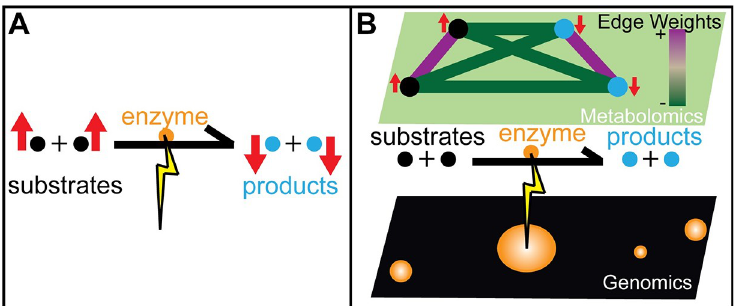
Fig 2. Latent covariance structure in the metabolome is induced by genetic perturbations of an enzyme. (A) Pathway visualization can unveil bottlenecks in metabolite flow when enzymes fail to function due to biallelic pathogenic mutations. Substrates are perturbed upwards and products are perturbed downwards around an affected enzyme. (B) Gaussian Markov Random Field (GMRF) networks model covariation relationships between metabolite perturbations, where each edge indicates a non-zero partial correlation between two given metabolites. When an enzyme’s function is deficient, substrate levels are perturbed upwards, product levels are perturbed downwards. This latent covariance structure within the GMRF model is characterized by positive covariance edges between substrates and between products and negative covariance edges between substrates and products.